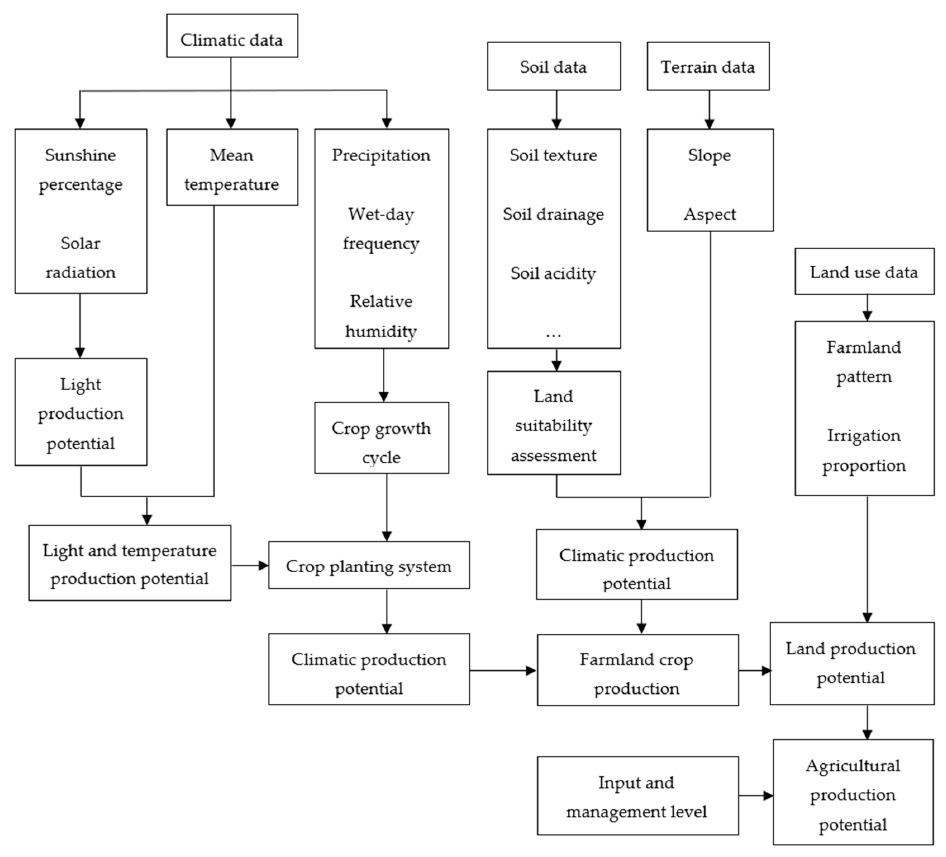
Figure 2. The flow chart of soybean production potential calculation using the Global Agro-Ecological Zones (GAEZ) model.